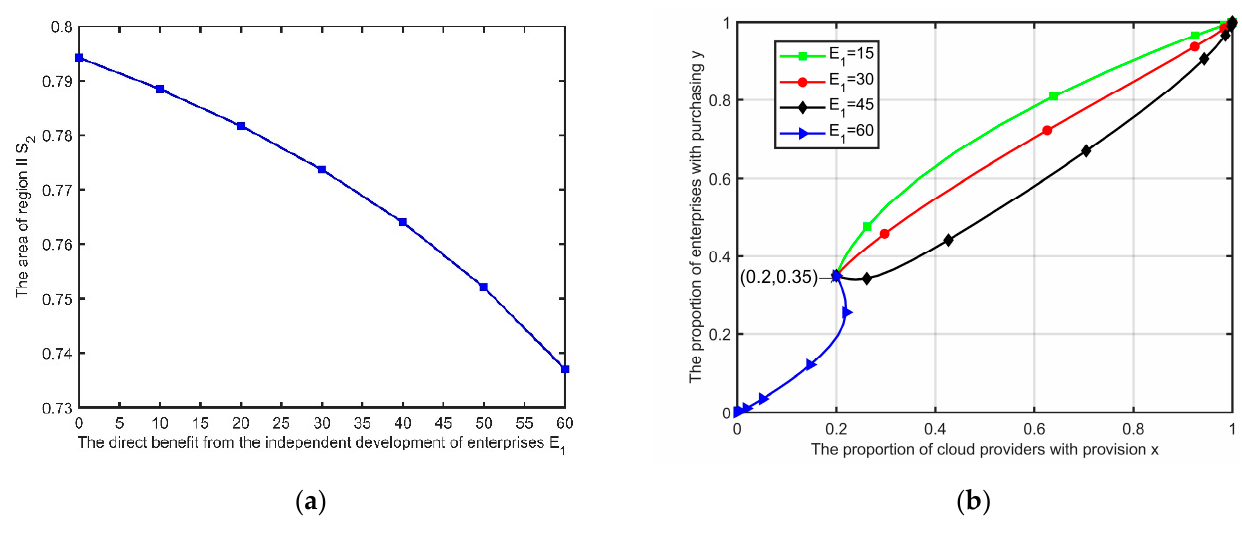
( a ) ( b ) Figure 5. The impact of 1 E on Ⅱ S and evolutionary paths ( a ) The impact of 1 E on Ⅱ S ; (b) The Figure 5. The impact of E 1 on S II and evolutionary paths ( a ) The impact of E 1 on S II ; ( b ) The evolutionary paths with different direct benefits E 1 evolutionary paths with different direct benefits 1 E .